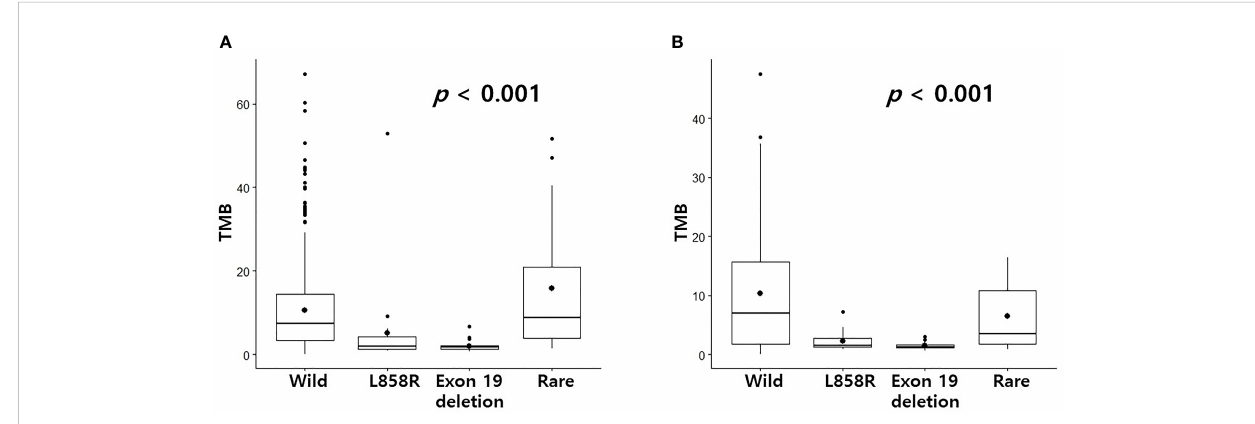
FIGURE 3 Differences in TMB according to EGFR mutational subtypes. Changes in levels of TMB according to EGFR mutational subtypes in pancancer dataset (A) and cptac dataset (B) . The small dot in the boxplot is the mean value.